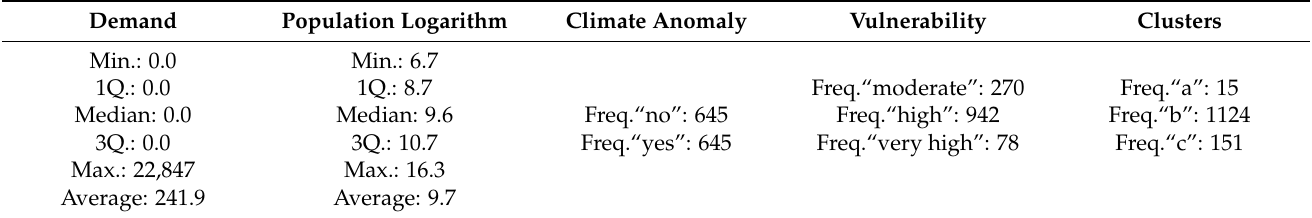
Table 2. Descriptive statistics or frequency of variables involved in the model.